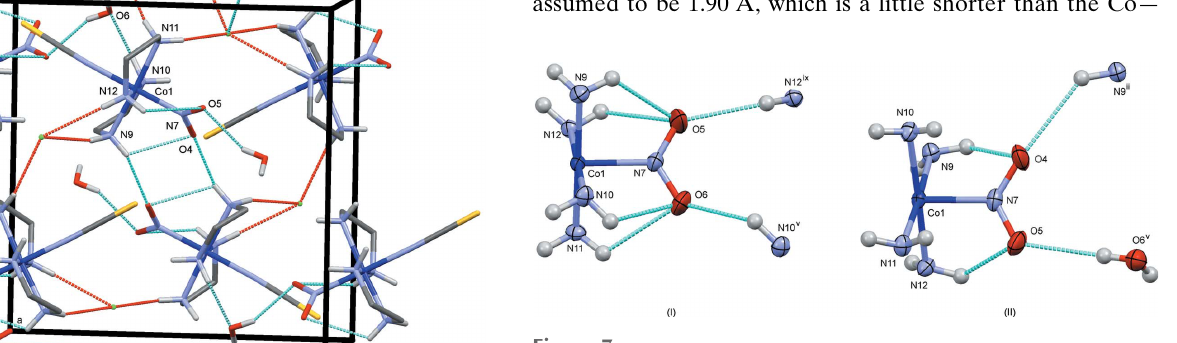
Figure 7 Comparison of the steric circumstances of the nitro group in (I) and (II). Dashed lines in blue indicate O(nitro) (cid:2)(cid:2)(cid:2) H short contacts shorter than 2.5 A˚ . Only part of the diamine ligands are shown for clarity. Symmetry codes for (I): (v) (cid:3) x + 1 , (cid:3) y + 1 , (cid:3) z ; (ix) x , (cid:3) y , z (cid:3) 1 . For (II): (ii) (cid:3) x + 1, 2 2 2 (cid:3) y + 1, (cid:3) z + 1; (v) x (cid:3) 1 , (cid:3) y + 3 , z + 1 2 2 2